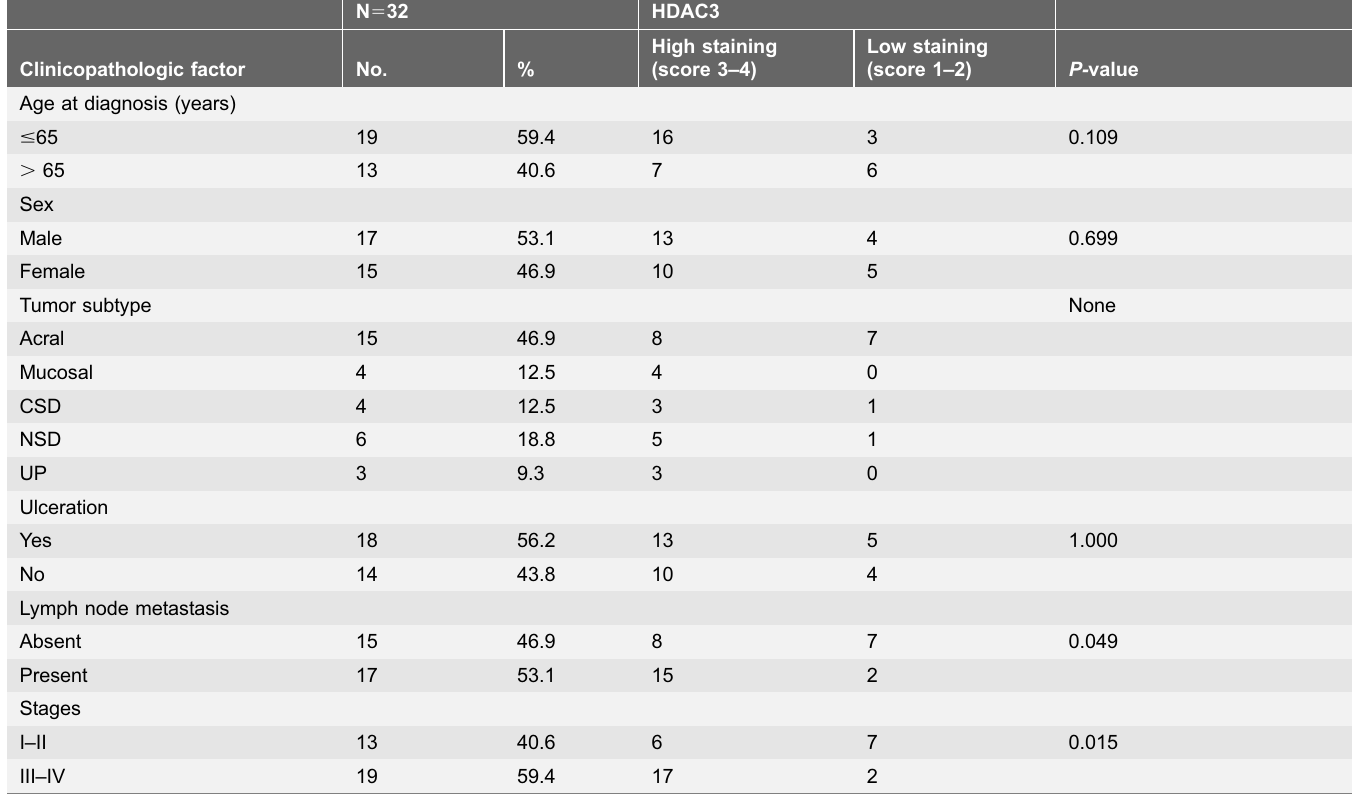
Table 1. Correlation of HDAC3 protein expression to clinicopathologic features of melanoma Patients. N 5